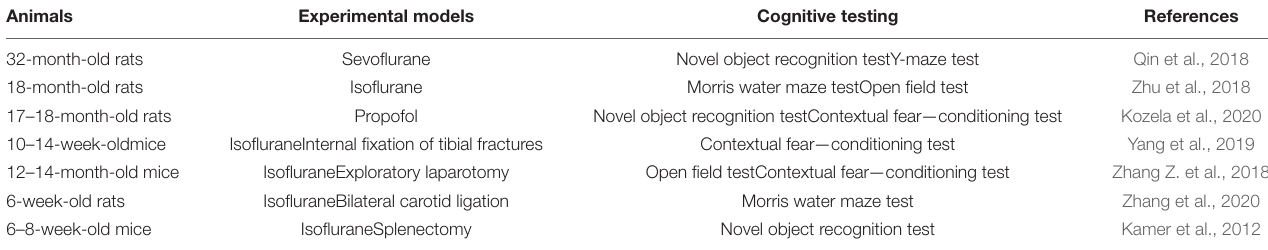
TABLE 2 | Animal models of postoperative cognitive